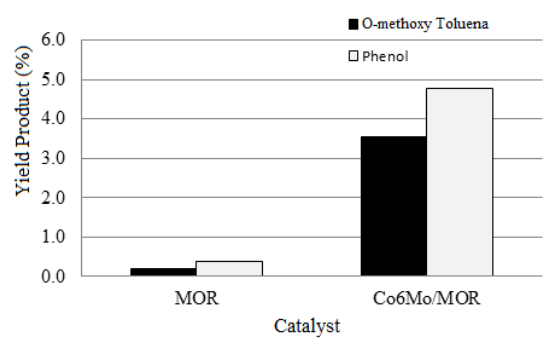
Figure 10: Product